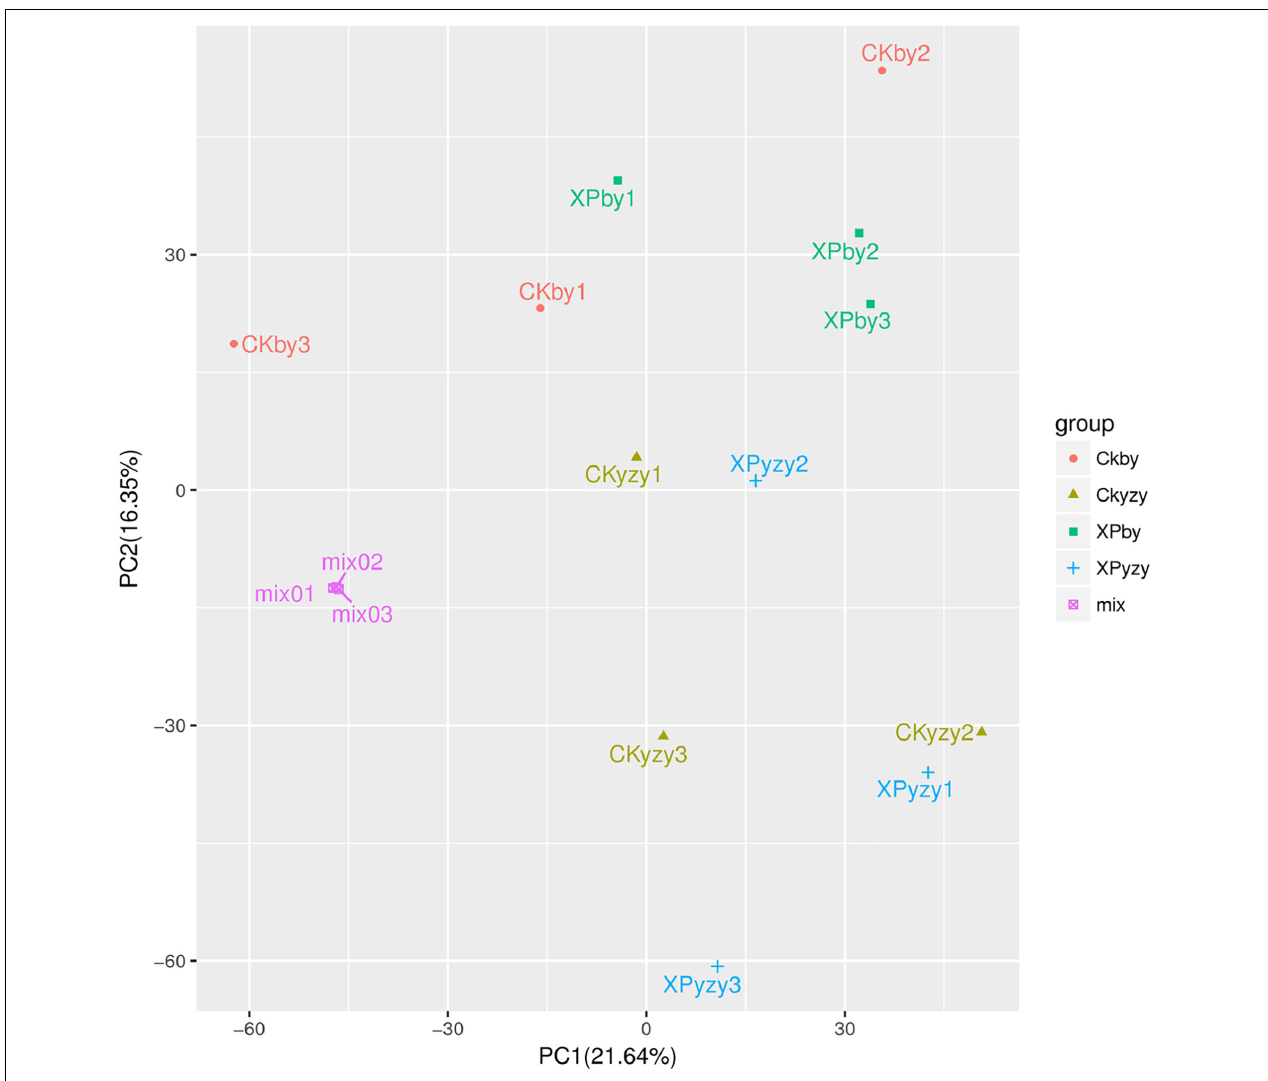
FIGURE 5 | Principal component analysis score plots of metabolic profiles in oat roots. CKby and CKyzy represent the control treatment of Baiyan7 (BY) and Yizhangyan4 (YZY), respectively; XPby and XPyzy represents the saline-alkali stress treatment of BY and YZY,